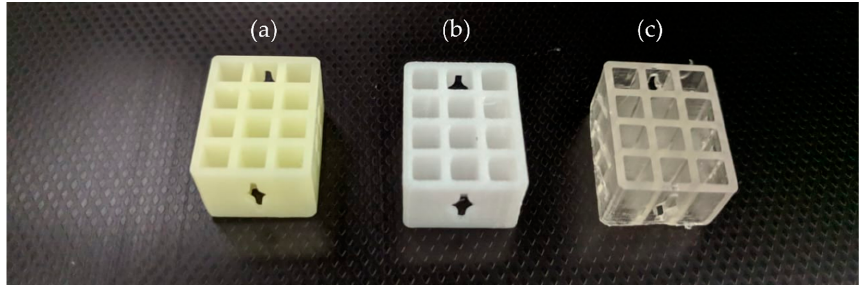
Figure 5. Photos of examples of manufactured and treated probes for geometrical and surface characterization for ( a ) DLP, ( b ) FDM, and ( c ) SLA. characterization for ( a ) DLP, ( b ) FDM, and ( c )